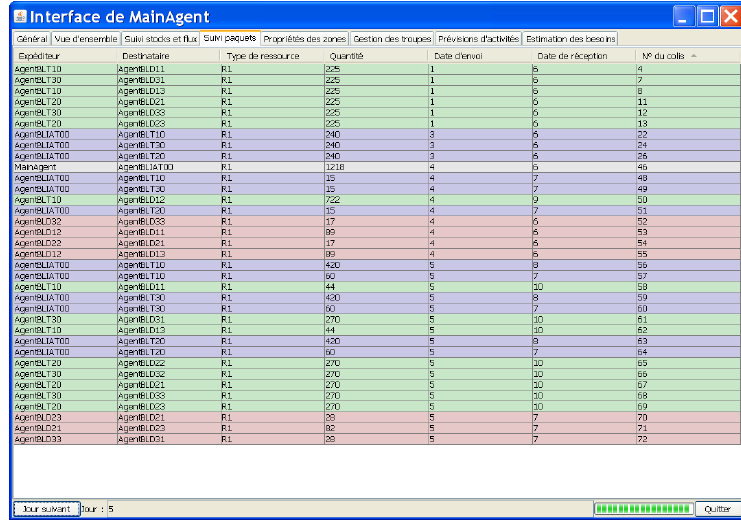
Fig. 8. Interface of tasks